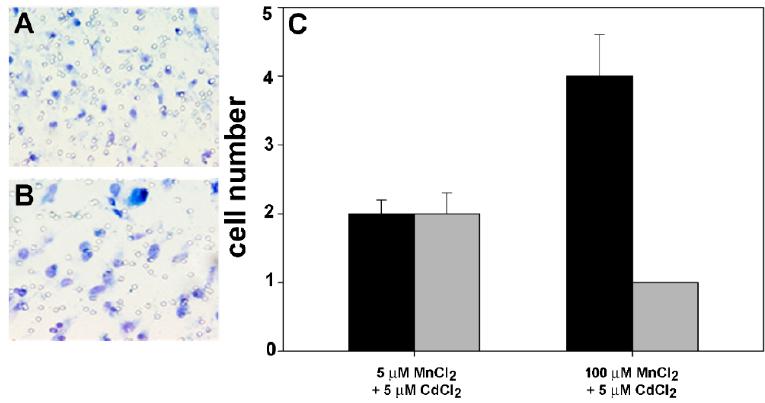
Figure 5. Representative low-magnification images captured at 6 h showing 5 µ M MnCl 2 /5 µ M CdCl 2 cotreated ( A ) and 100 µ M MnCl 2 /5 µ M CdCl 2 cotreated MDA-MB231 cells ( B ) migrated through the filter pores in chemotaxis assays. Microscopic magnification = 40 × . ( C ) Histogram showing the number of migrated cells in chemotaxis (black bars) and chemoinvasion assays (gray bars) in the different experimental conditions. The results are expressed as the mean ± standard error of the mean (SEM) of six different experiments.